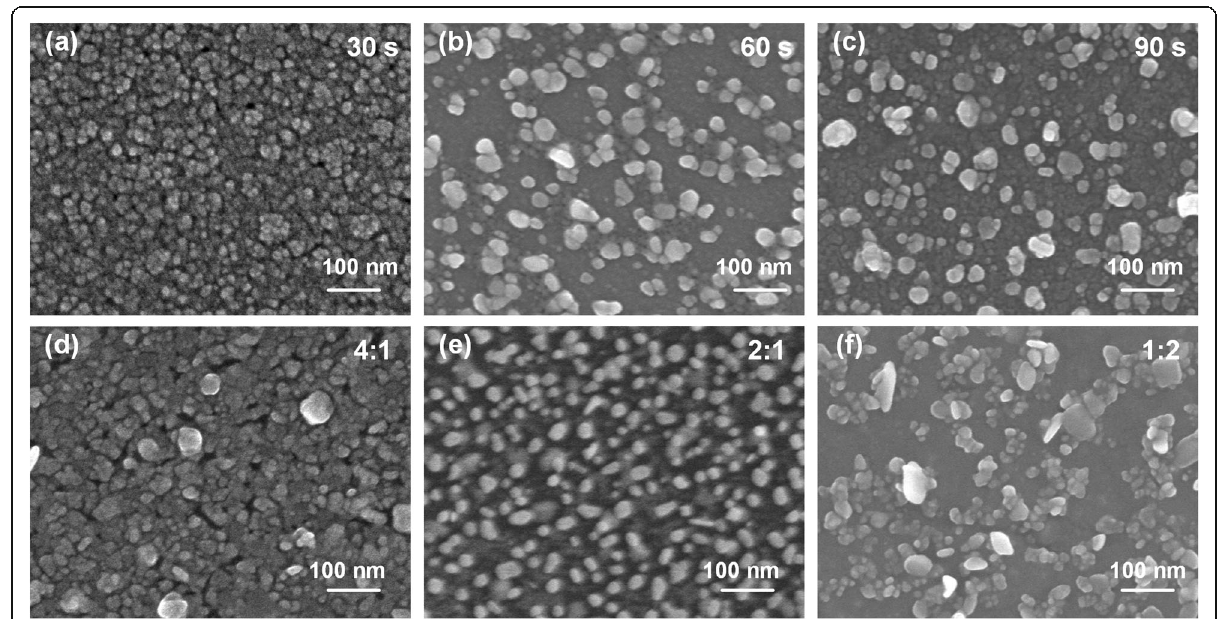
Fig. 3 SEM images of Ag NPs prepared on glass slides at 1:1 power rate with different (Ag, Al) co-sputtering time ( a – c ) indicated (30 s, 60 s, 90 s, respectively) and at 60 s with different (Ag, Al) power ratio ( d – f ) indicated (4:1, 2:1, 1:2 respectively)